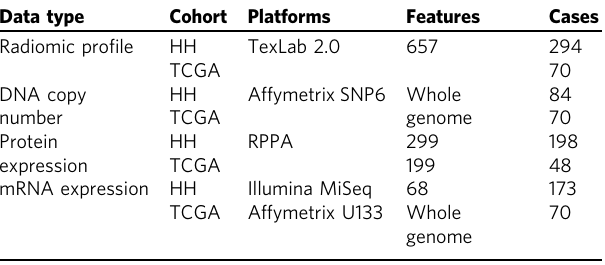
Table 1 Summary of data